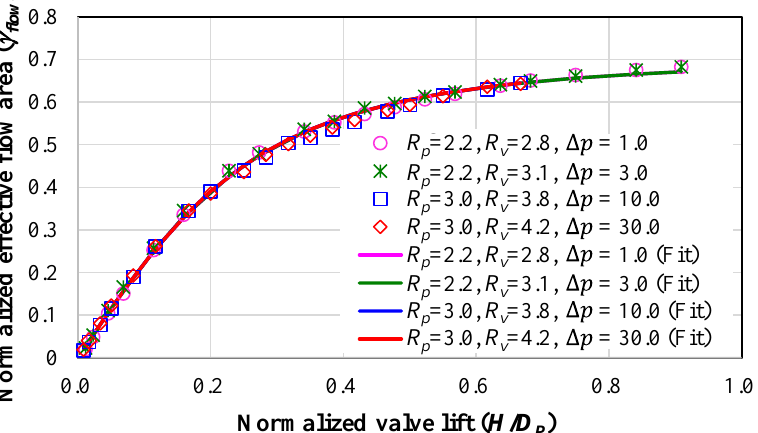
Figure 6. Normalized effective flow area for various geometries and pressure differences, and fitted results.